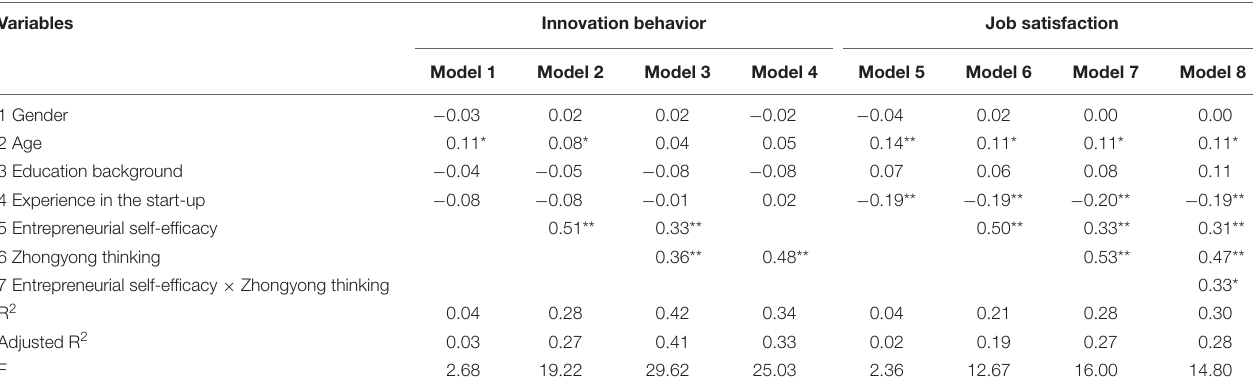
TABLE 4 | Regression analysis of